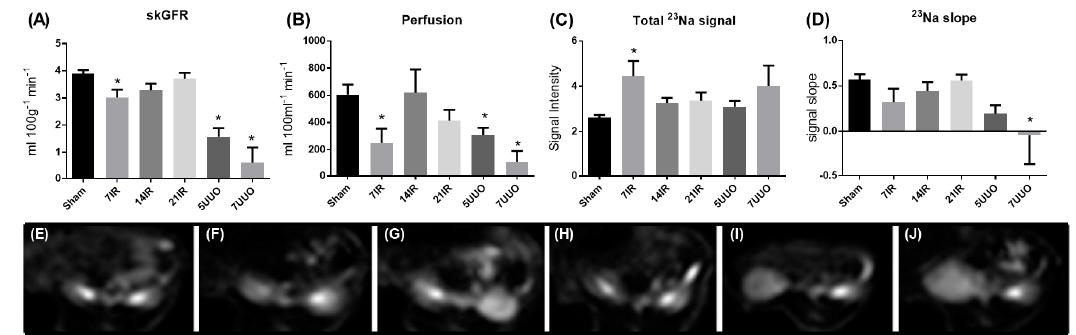
Figure 4. MRI data: ( A ) single-kidney glomerular filtration rate (skGFR) values calculated from the dynamic contrast enhanced (DCE) sequence, ( B ) perfusion calculated from the DCE sequence, ( C ) total 23 Na signal in the kidney normalized to back muscle 23 Na signals, and ( D ) slope of the 23 Na signal from the cortex to inner medulla. ANOVA with Bonferroni multiple comparison test was performed between sham, IRI, and UUO. Each bar represents the mean ± SEM, * p < 0.05 compared to sham group ( n = 6). Representative images of the 23 Na signal from ( E ) the sham group ( n = 6), ( F ) 7 days after bilateral ischemia reperfusion injury (IRI) ( n = 6), ( G ) 14 days after bilateral IRI ( n = 4), ( H ) 21 days after bilateral IRI ( n = 5), ( I ) 5 days of unilateral ureteral obstruction (UUO) ( n = 6), and ( J ) 7 days of UUO ( n = 6).